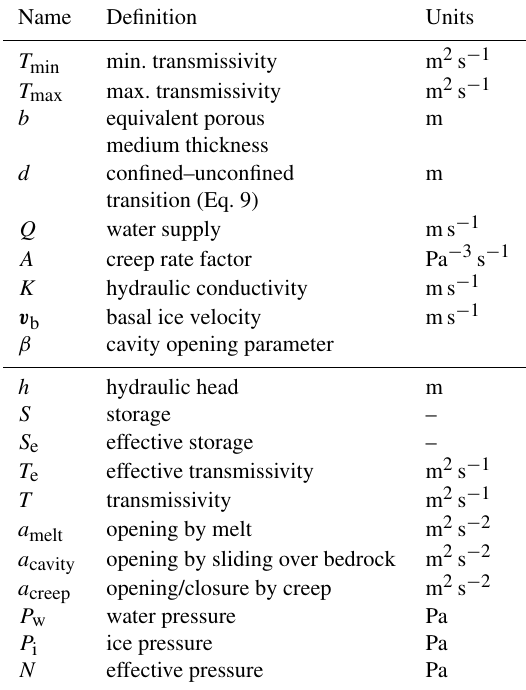
Table 2. Model parameters (upper) and variables computed in the model (lower)